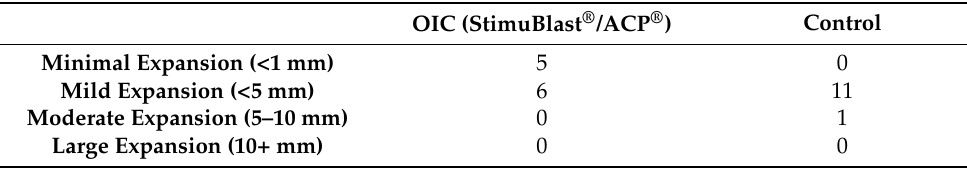
Figure 4. The figure shows the tunnel diameters measured from the post-operative MRI scans. Values for StimuBlast ® /ACP ® for the OIC (white) and control (grey) groups are reported for both the femur and tibia. Table 3. Summary of femoral tunnel expansion by categorical size.